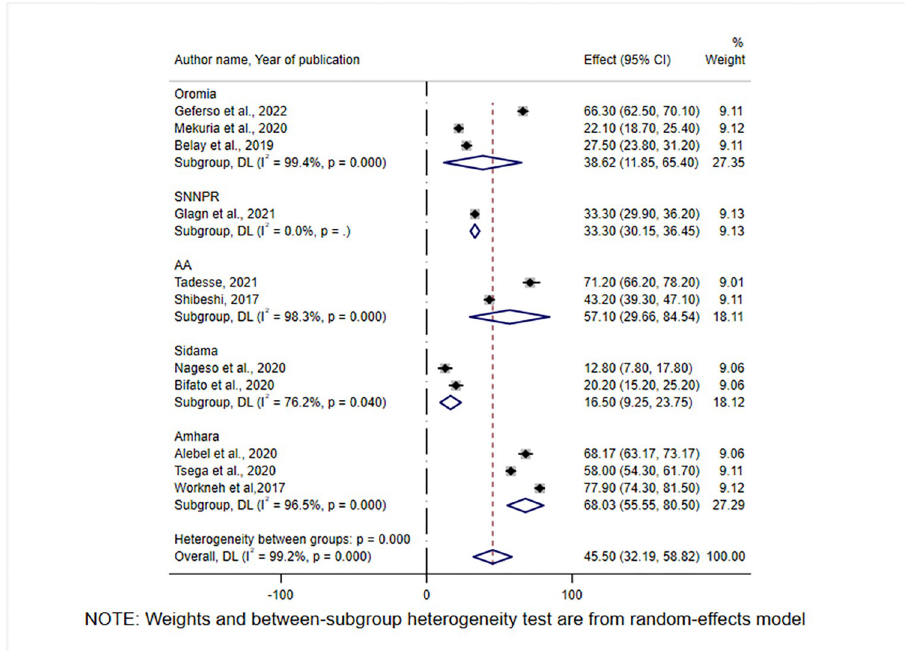
Fig 3. Forest plot showing subgroup analysis of CBHI enrolment by geographical regions of Ethiopia, 2017–2022.